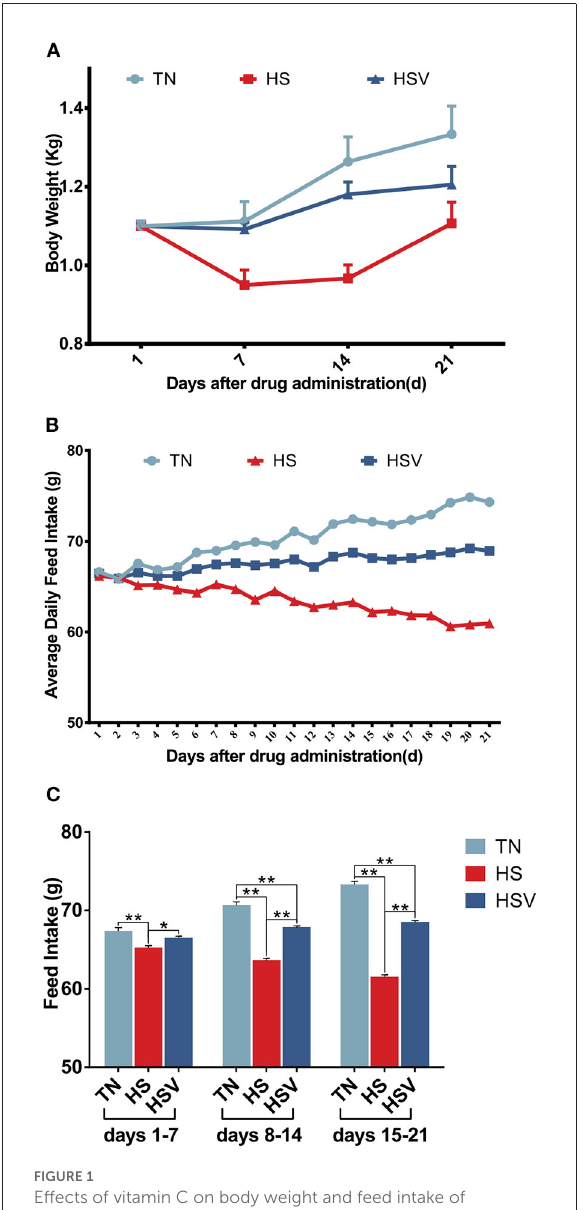
FIGURE1 Effects of vitamin C on body weight and feed intake of chronically heat-stressed laying hens. (A) body weight; (B) average daily feed intake; and (C) feed intake. Data are expressed as mean ± SEM ( n = 6). * indicates a significant difference ( * P < 0.05 and ** P < 0.01). Same as